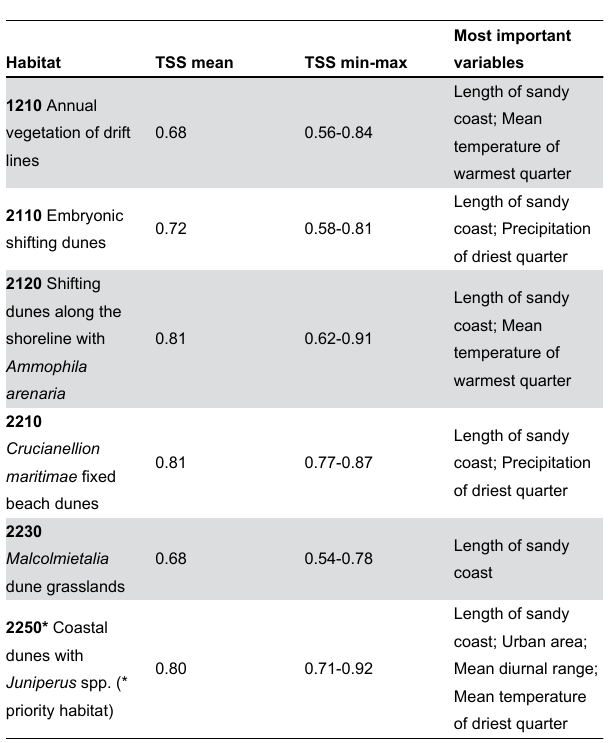
Table 2. Indirect models evaluation.